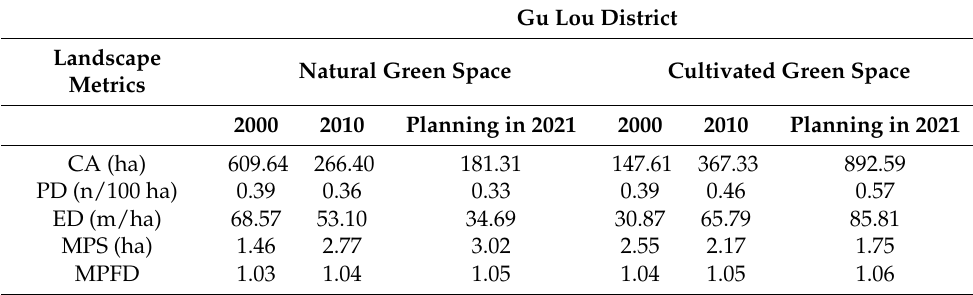
Table A2. The comparison of landscape metrics on class level of Gu Lou district.